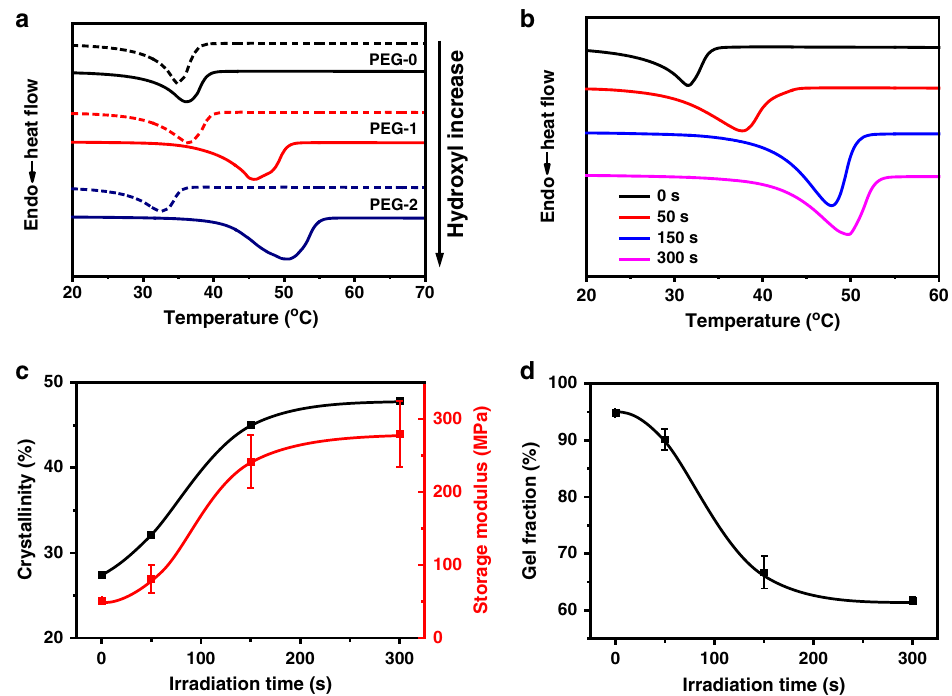
Fig. 2 Programming thermomechanical properties via network topological isomerization. a DSC curves of the network samples before (dotted lines) and after (solid lines) isomerization. b DSC curves for the isomerized PEG-2 samples obtained with different UV irradiation times. c Room temperature storage modulus (25 °C) and PEG crystallinities of the isomerized samples. d Gel fraction of the isomerized network samples. Error bars represent standard deviations calculated from three